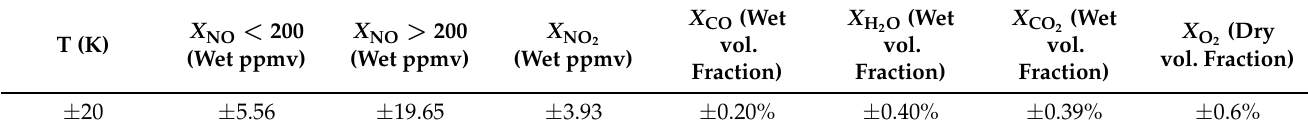
Table 1. Experimental uncertainties (95% confidence